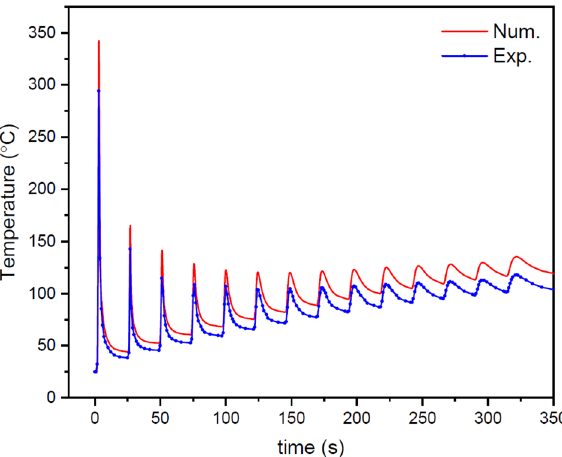
Figure 5. Comparison of thermal histories obtained from the FE model (red) and experimental measurements (blue) at the same